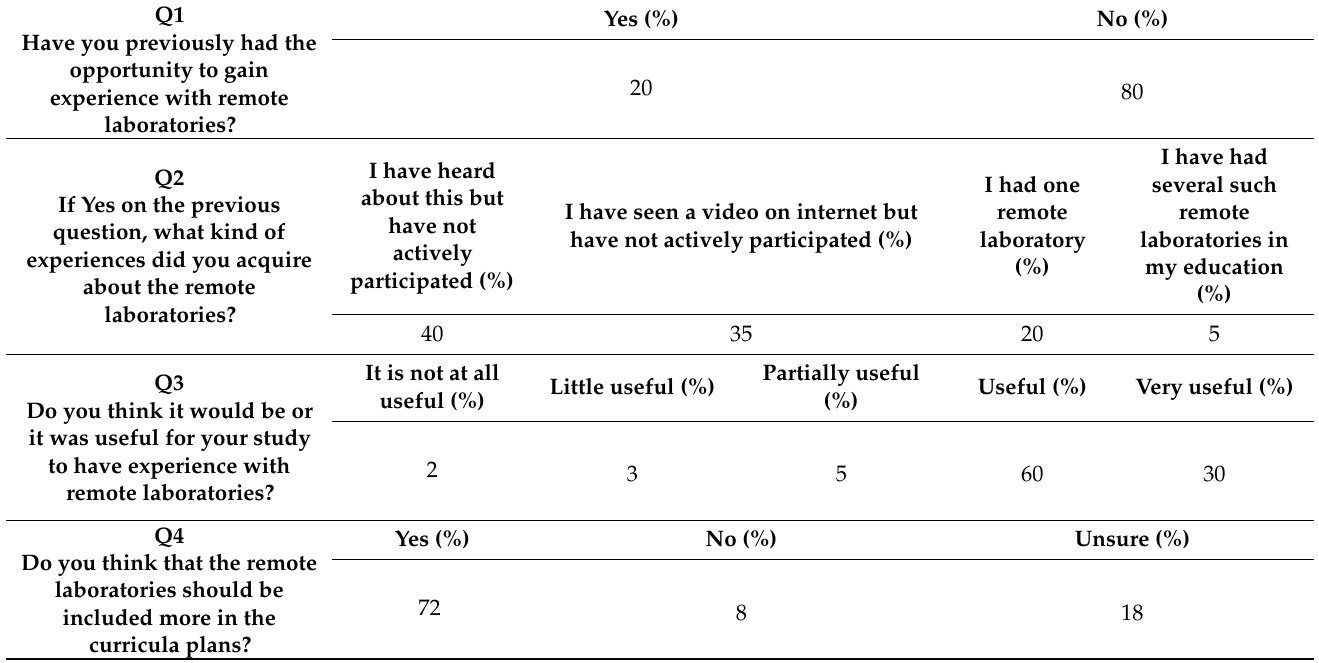
Table 4. Students’ responses to expectation